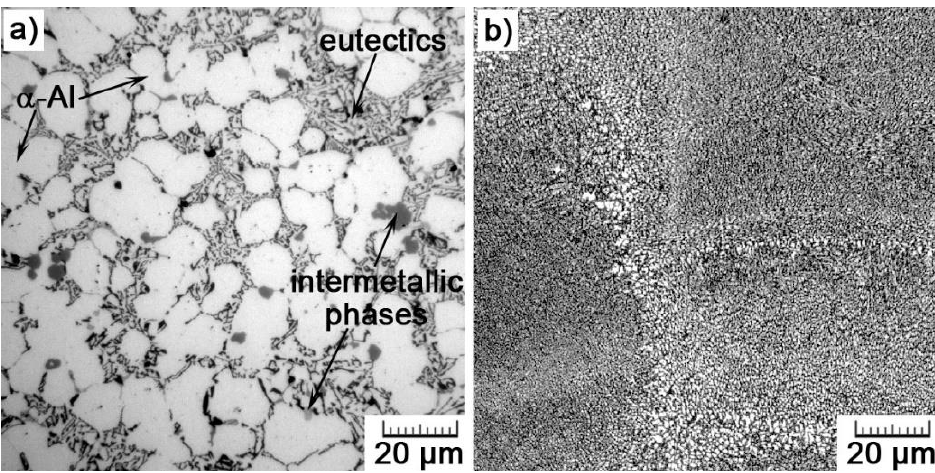
Figure 8. Comparison between ( a ) as-cast (HPDC) and ( b ) SLM